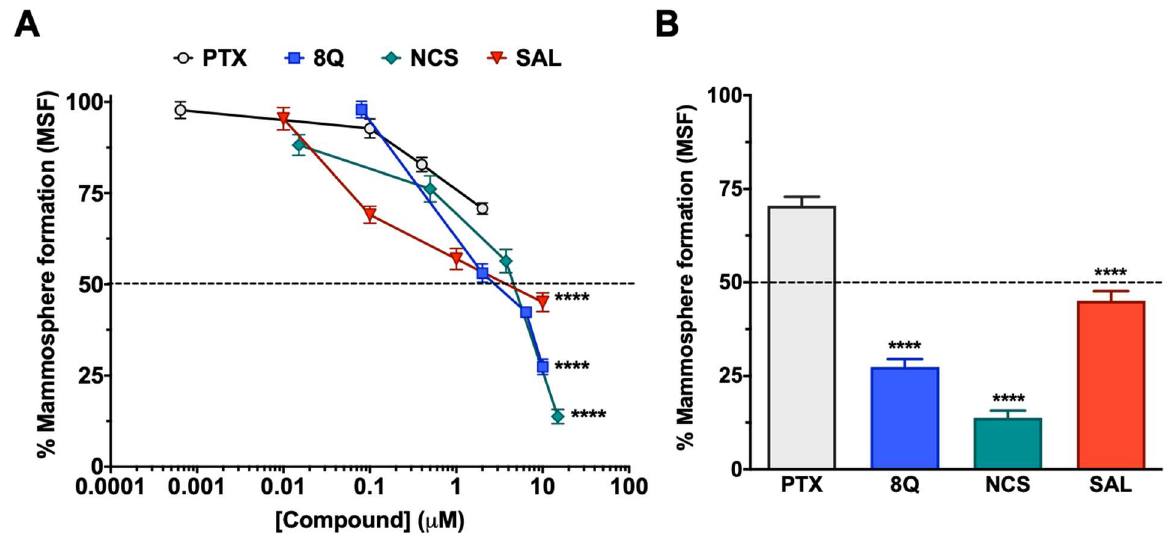
Figure 2. Anti-CSC activity of selected compounds in the MDA-MB-231 CSC population cultured under low attachment conditions. ( A ) Dose-response curves of the CSC mammosphere-forming efficiency (MSF) of MDA-MB-231 cells after drug treatments. ( B ) Percentage of mammosphere after 7-day incubation with 2 µM PTX, 10 µM SAL and 8Q, and 15 µM NCS. Statistically significant results were obtained for all tested compounds when compared to PTX. Data are represented as the mean ± SEM of three independent experiments. **** p < 0.0001.